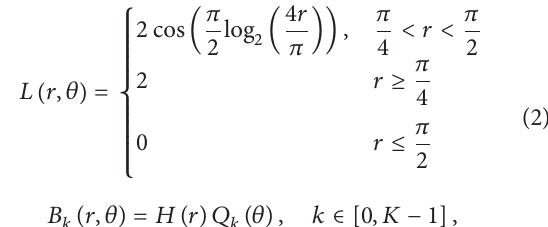
Figure 3: A simple ELM